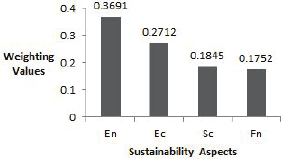
Figure 2. Weighting values of sustainability aspects